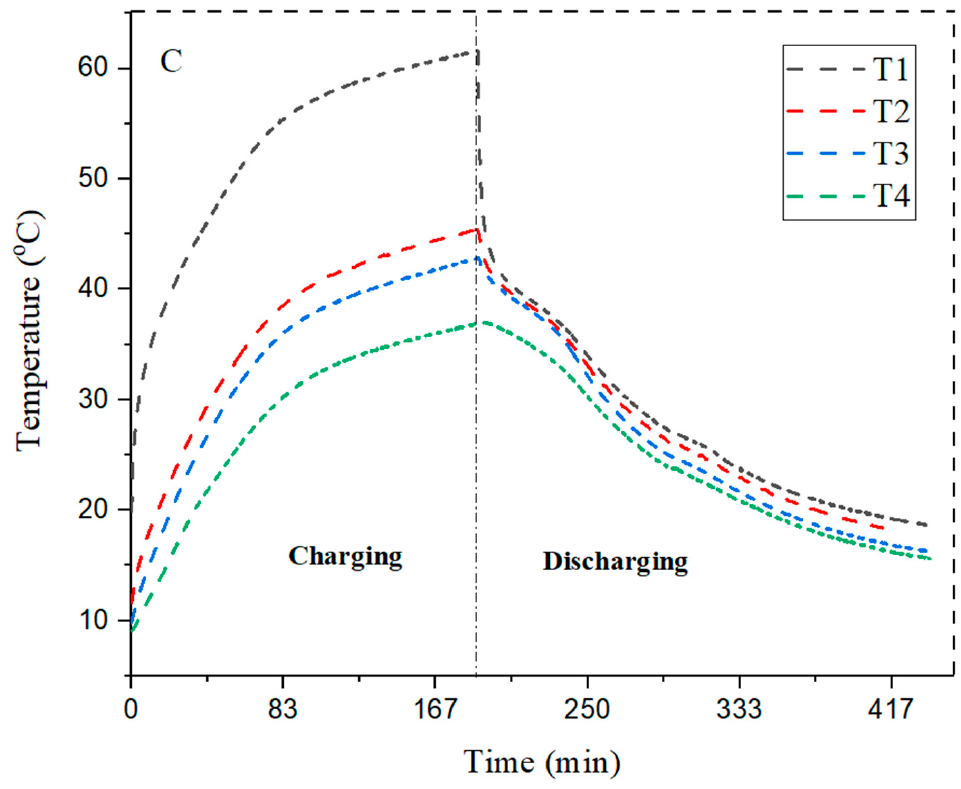
Figure 8. Comparison of different configurations with PCM ( A ) circular, ( B ) square, and ( C ) triangular fins. Table 5. Temperature data for configuration with 3 wt%